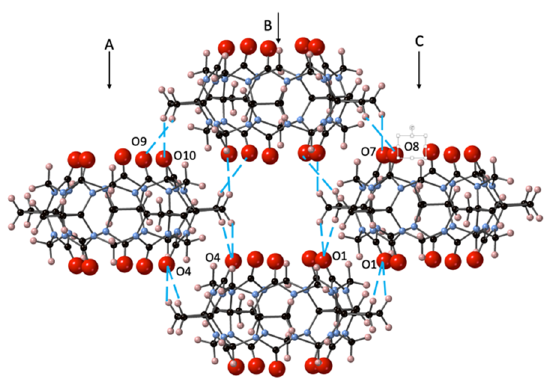
Figure 2. The crystal packing of CyB 5 Q[5] · 7H 2 O ( 1 ) with the dipole–dipole interactions between portal C=O and cyclobutano CH 2 protons indicated (– –) for a set of 4 CyB 5 Q[5] representing a segment of columns A, B, and C. The H 2 O was omitted for clarity.